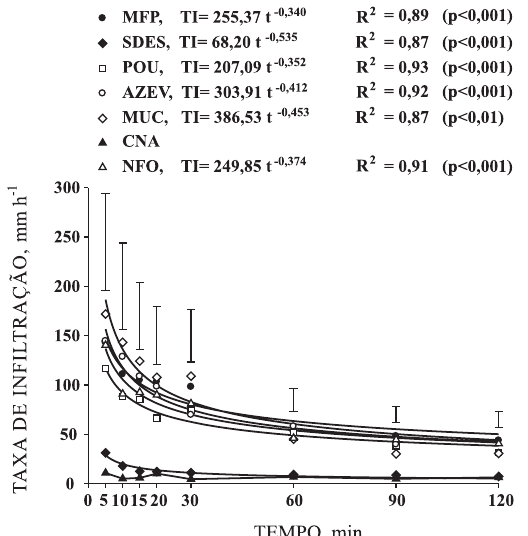
Figura 2. Taxa instantânea de infiltração de água em um Argissolo Vermelho submetido a diferentes sistemas de culturas em plantio direto, após 16 anos de experimentação. (MFP: milho + feijão- de-porco/soja; SDES: solo descoberto; POU: milho/pousio/soja; AZEV: milho/azevém + ervilhaca/soja; MUC: milho + mucuna/soja; CNA: campo nativo; NFO: milho/nabo forrageiro/soja). As barras verticais correspondem à diferença mínima significativa pelo teste de Tukey (p <